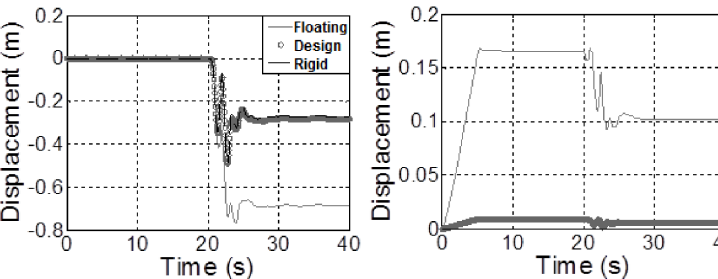
Fig. 7. Displacements in the longitudinal direction at top (Node 19 – left) and at bottom (Node 148 – right) of tower GTS 01, due to rupture of conductor cable bundle 01, for the three support types